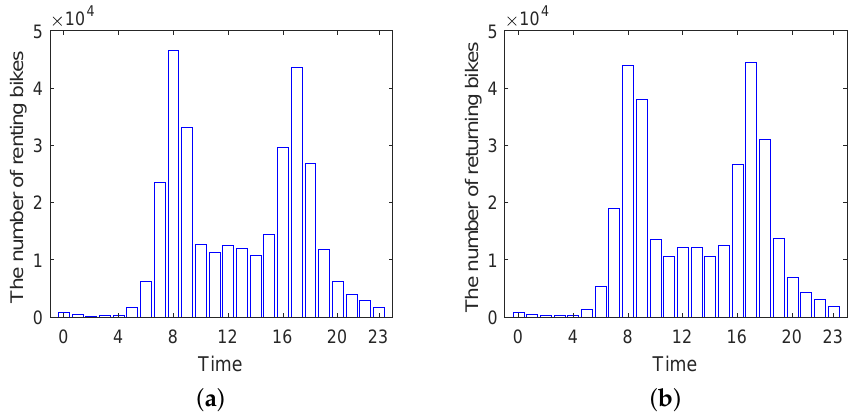
Figure 4. The renting and returning bikes by hours. ( a ) Renting by hours; ( b ) Returning by hours.